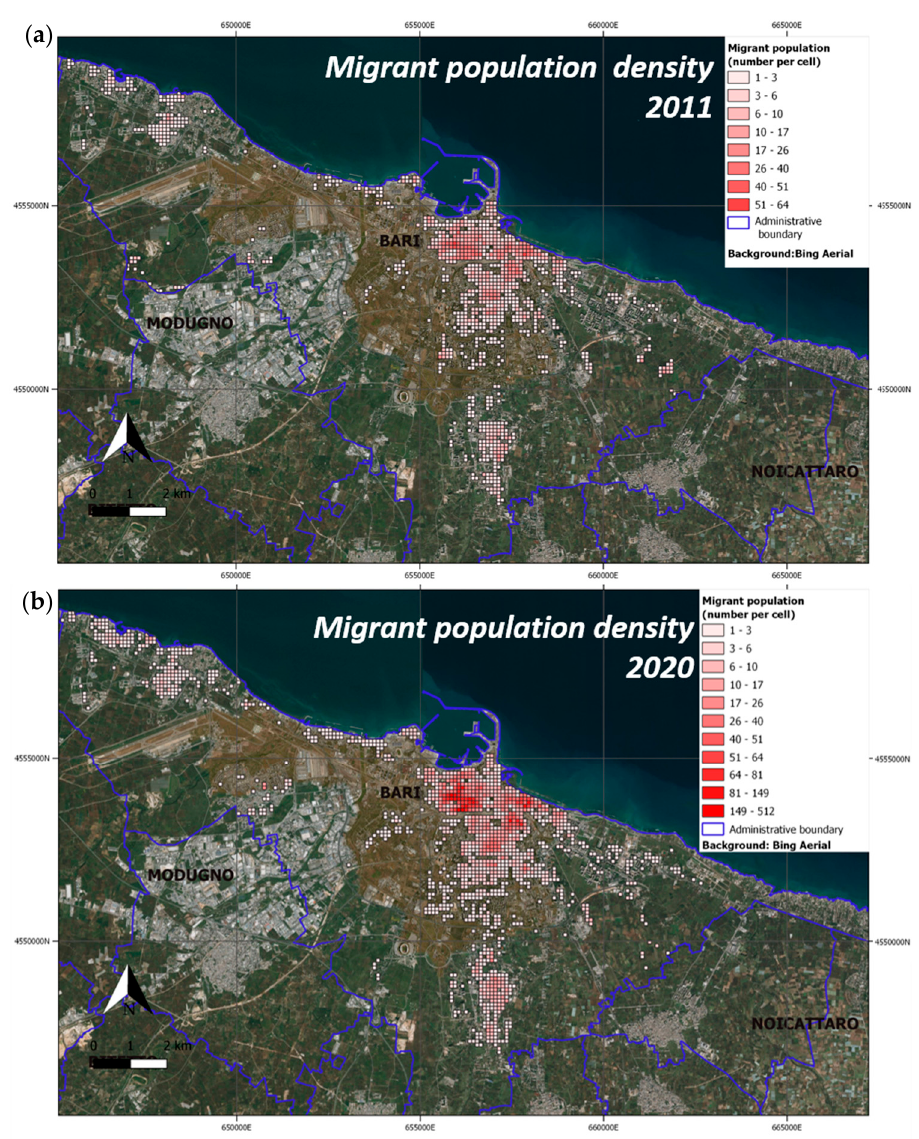
Figure 15. Grid population map for migrant population component in 2011 ( a ) and 2020 ( b ).